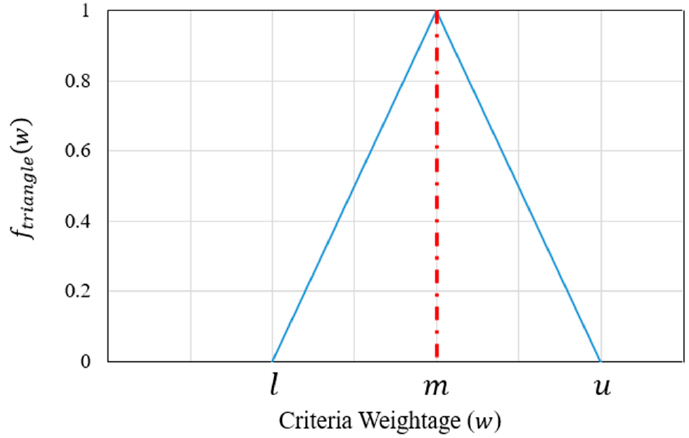
Figure 1. A typical fuzzy triangular number and its weight.